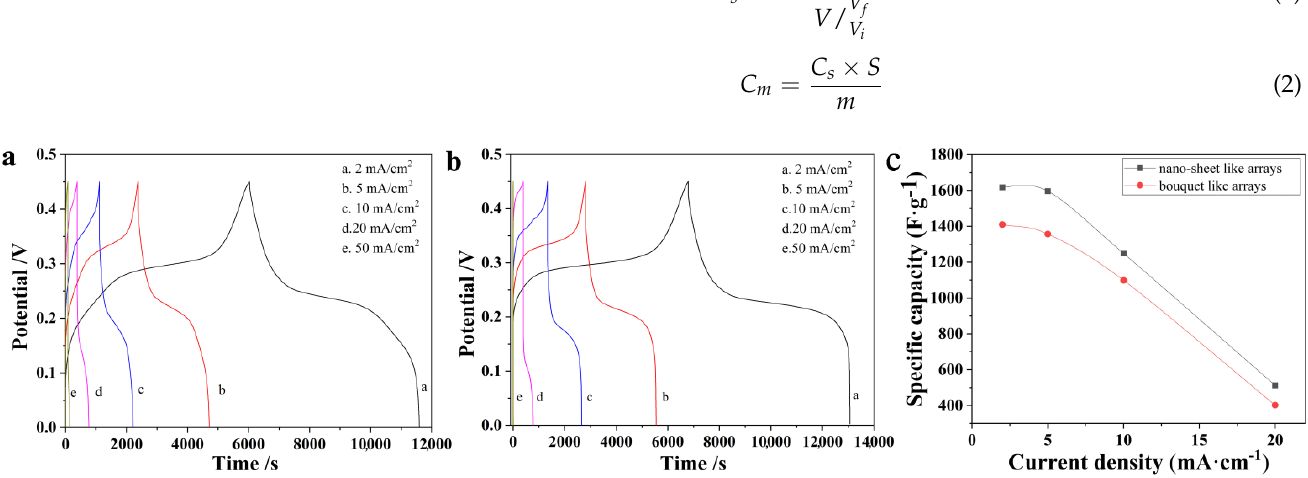
Figure 5. GCD curves of ( a ) MHP bouquet arrays/ACF composite electrode; ( b ) MHP nano-sheet arrays/ACF composite electrode; ( c ) Specific capacity of MHP/ACF composite electrode.